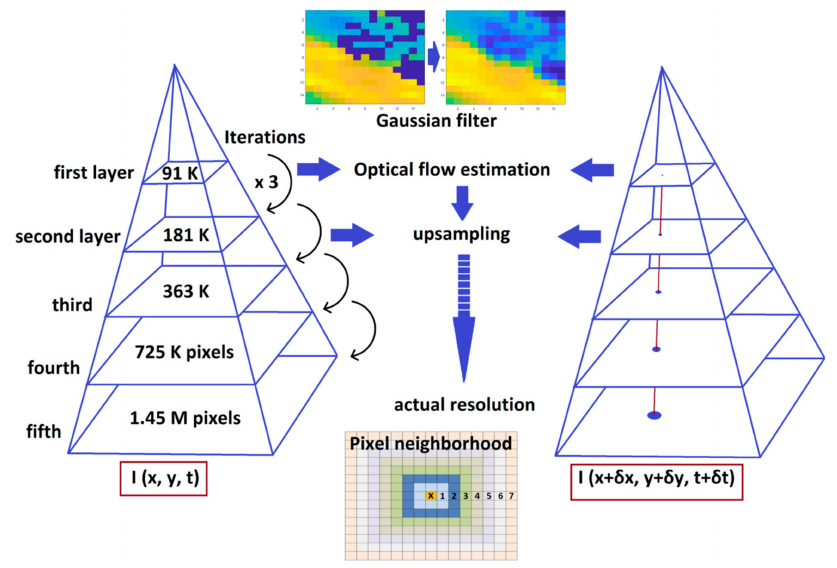
Figure 2. Flowchart illustration of the Farnebäck (FRB) scheme of this